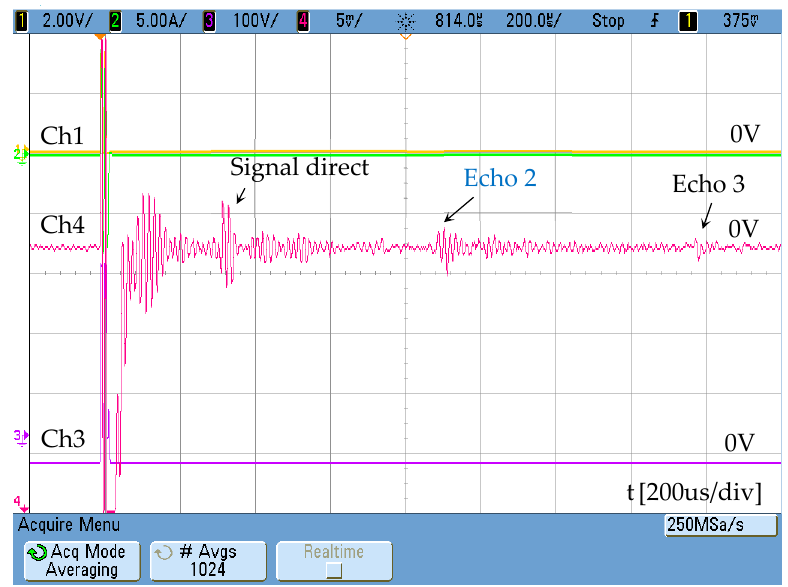
Figure 21. Signal obtained in the receiver configured according to the new magnetostrictive transducer with pre-magnetized strip Ch4: [5 mV/div]. Ch1 shows the activation signal of the power stage [2 V/div] and Ch3 the voltage at resonant circuit [100 V/div]. The maximum AC current is 5 A.